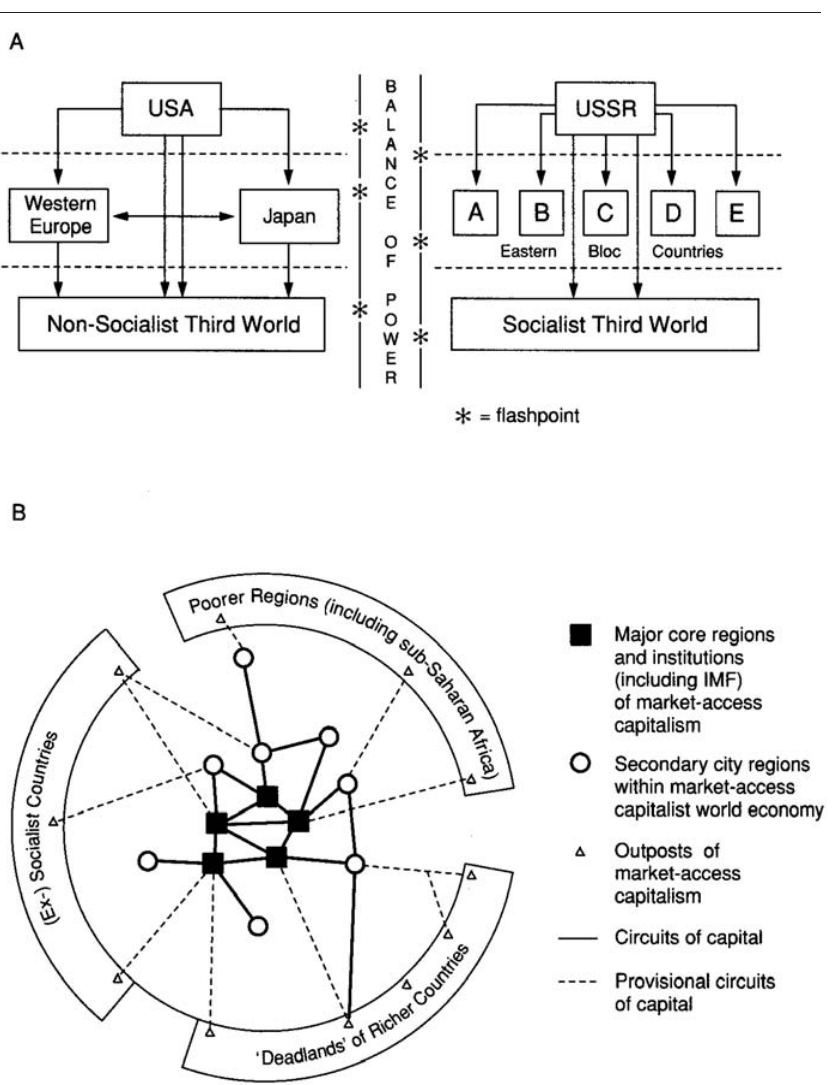
Figure 1: Schematic Representations of the Cold War and Post- Cold War World Economies.